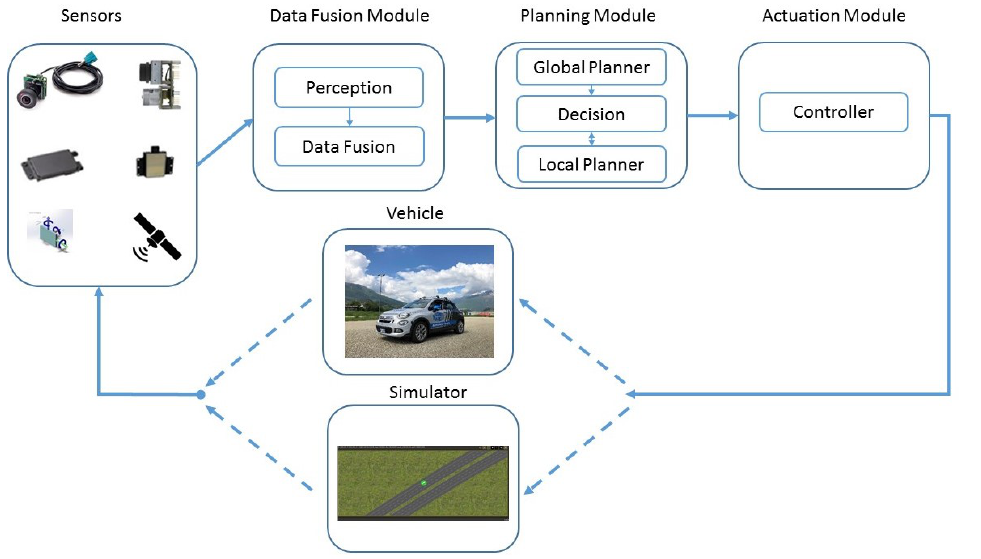
Figure 1. The high-level structure of our ADS. The sensor system, made up of about 30 different sensors, collects adequate information about the vehicle’s surrounding area in real time. Starting from this information, the data-fusion unit builds occupancy grid maps, and it detects the free areas around the vehicle. Given this environmental information, the planner generates the collision-free trajectories the vehicle is supposed to follow. Based on the selected path, the controller generates commands for the vehicle, and it verifies its dynamic behavior. Finally, a real car (or a vehicle simulator) follows the controller’s commands, and it closes the ADS loop